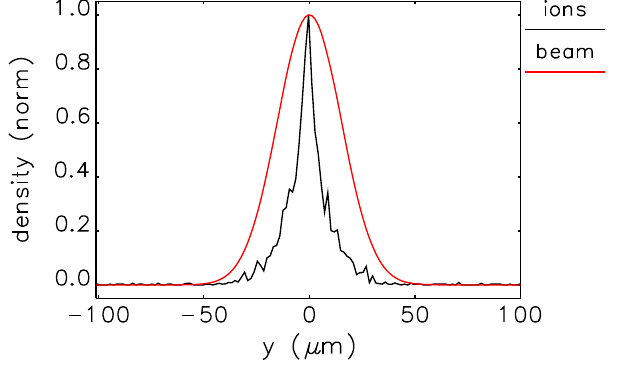
FIG. 6. Vertical ion distribution, after three turns, at IP1.